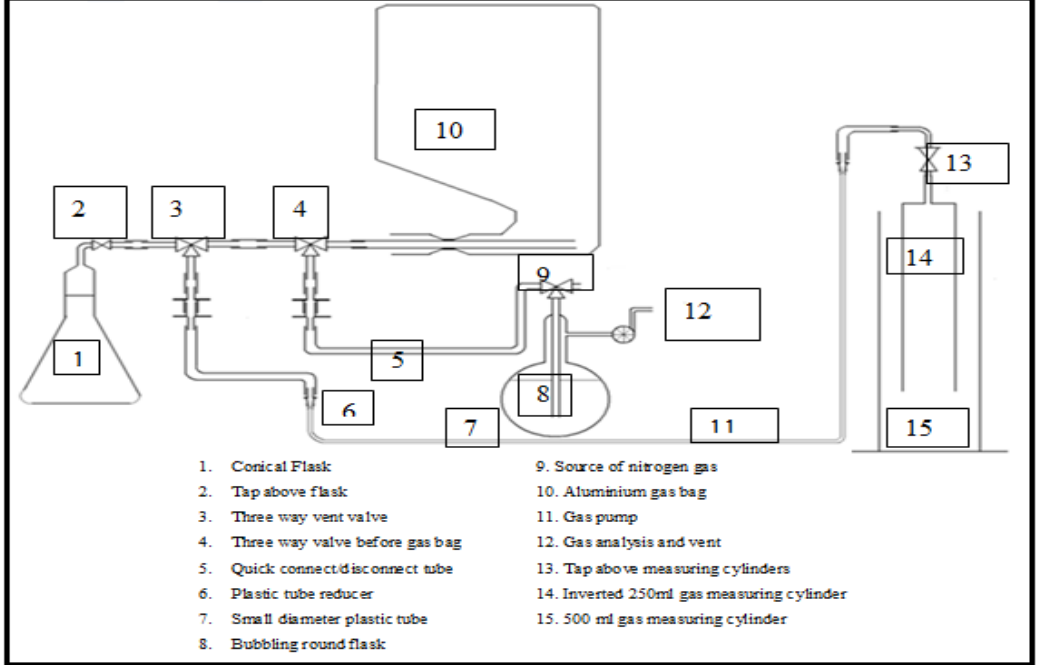
Figure 3. Apparatuses and equipment used in the preparation of the samples.